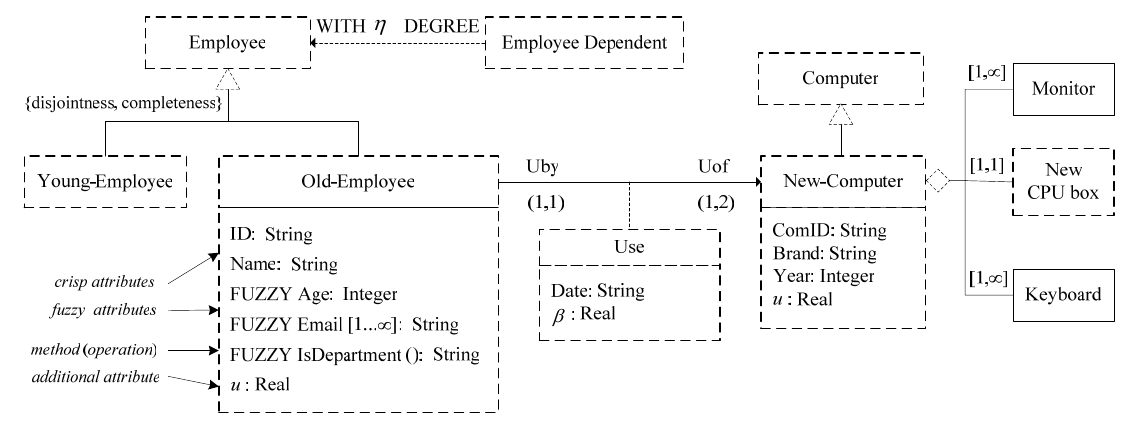
Fig. 6. A graphic fuzzy UML model F UML1 .